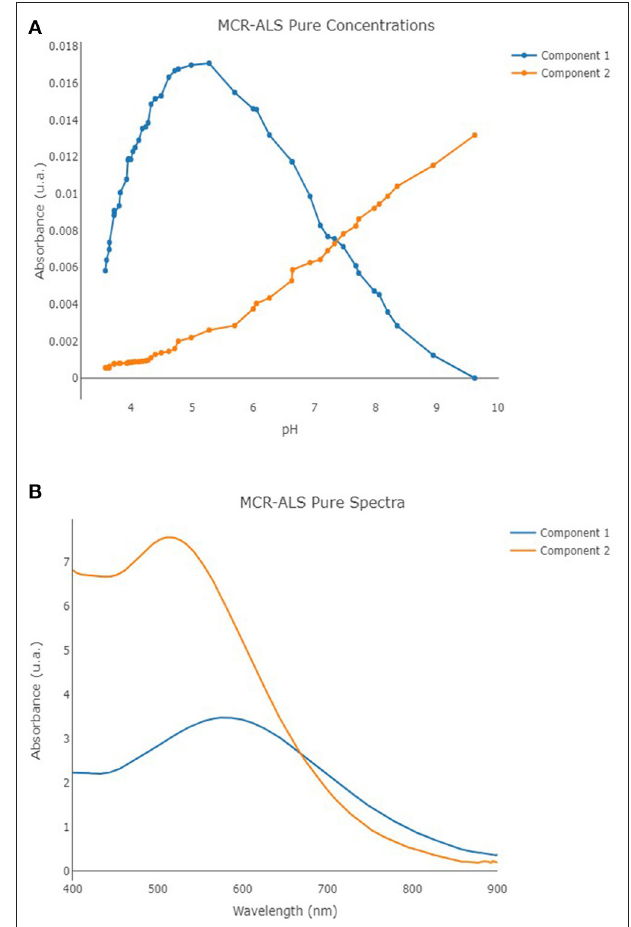
FIGURE 7 | Component 1 (blue line) and component 2 (orange line) pure concentrations (A) and pure spectra (B) profiles for the developed MCR-ALS model.